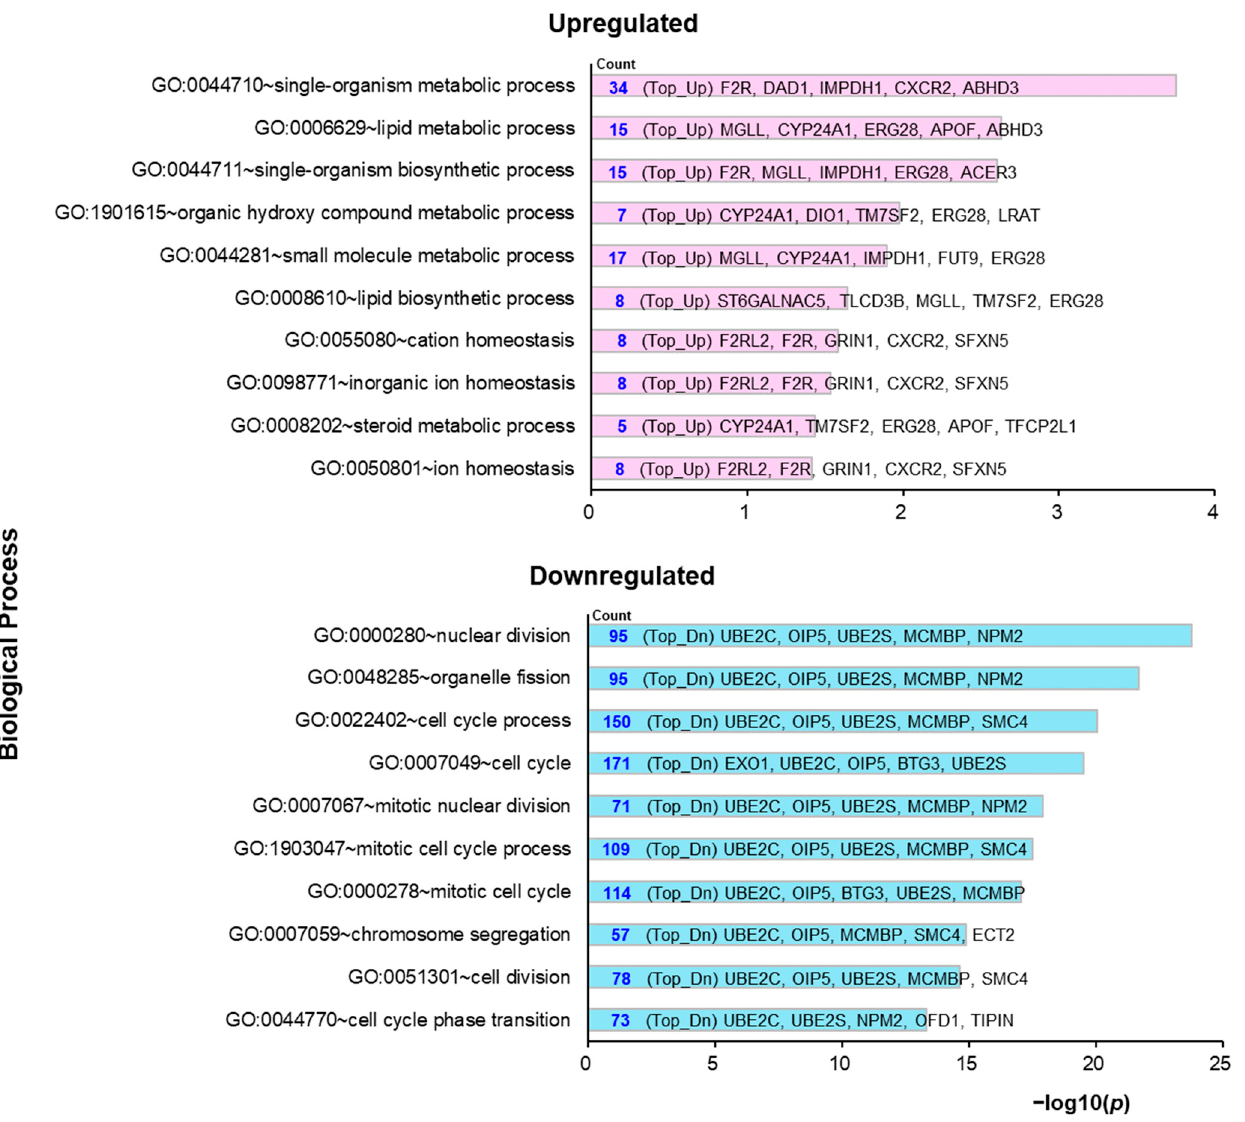
Figure 3. GO pathway analysis for preventive administration of GTE compared with OF. The top 10 enriched GO functions for upregulated (Top_Up, pink) and downregulated (Top_Dn, blue) are shown in the − log10 p -value ( − log10( p )). GO, Gene Ontology; GTE, green tea extract; OF, overfeeding.